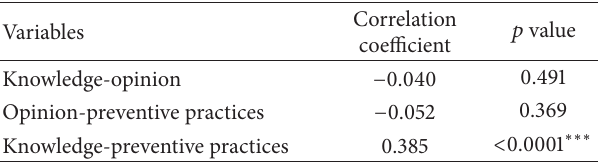
Table 5: Correlation among knowledge, opinion, and preventive practices